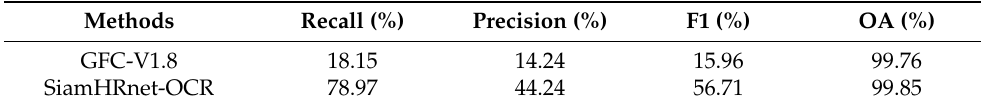
Table 12. Accuracy